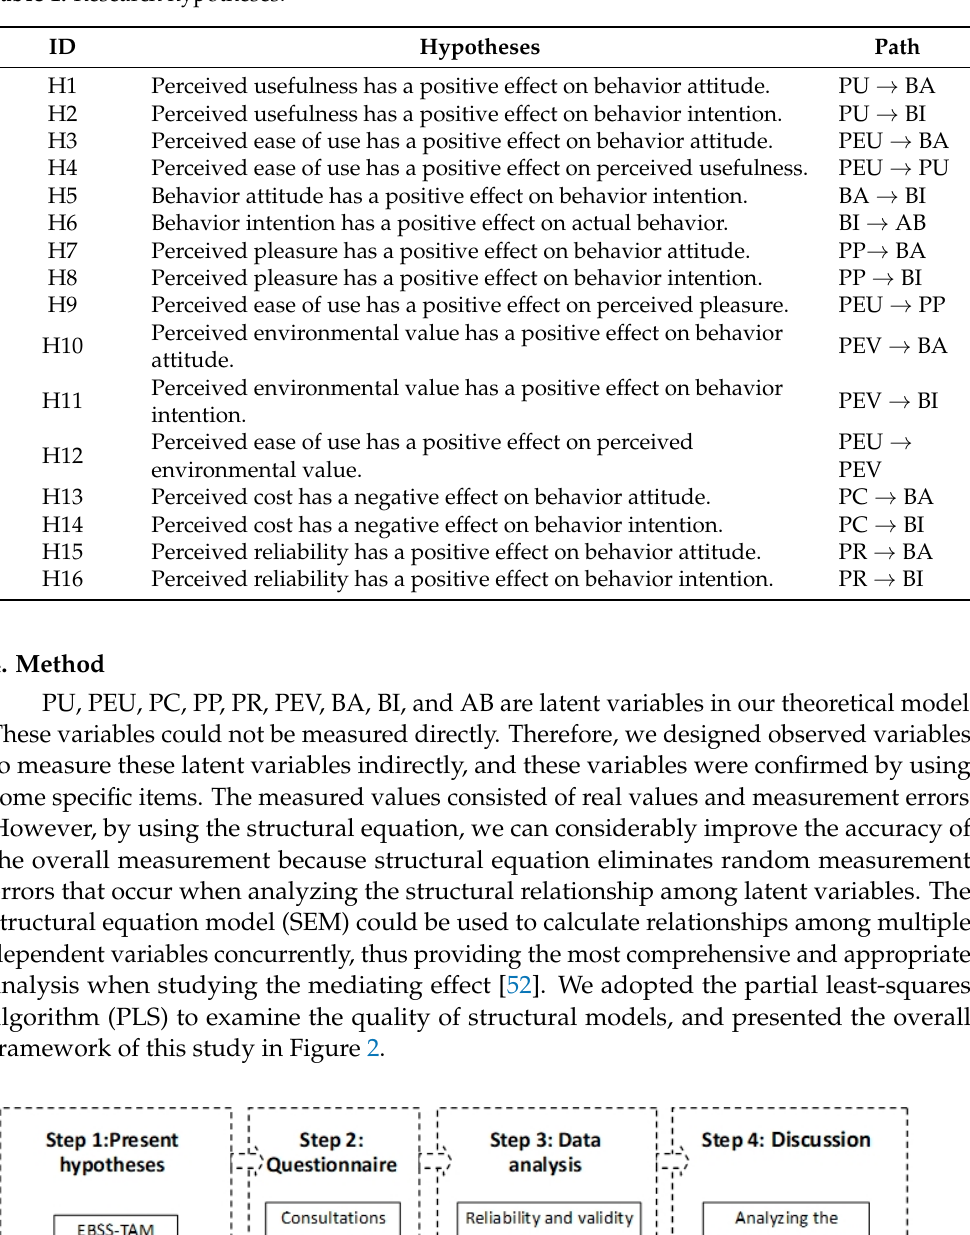
Table 2. Measurement scale items.